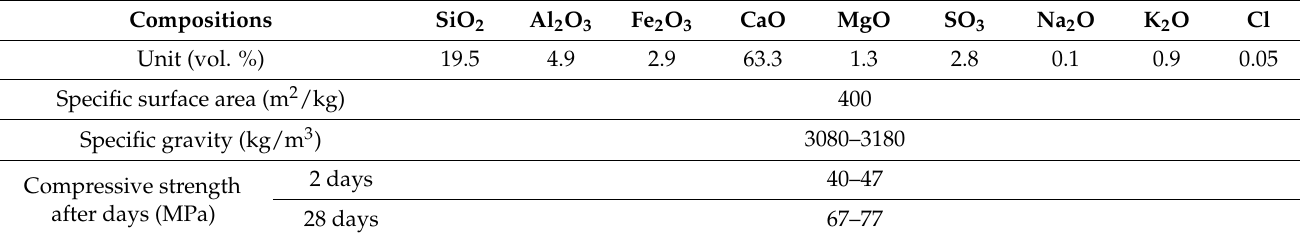
Table 1. Chemical composition of the cement [51].